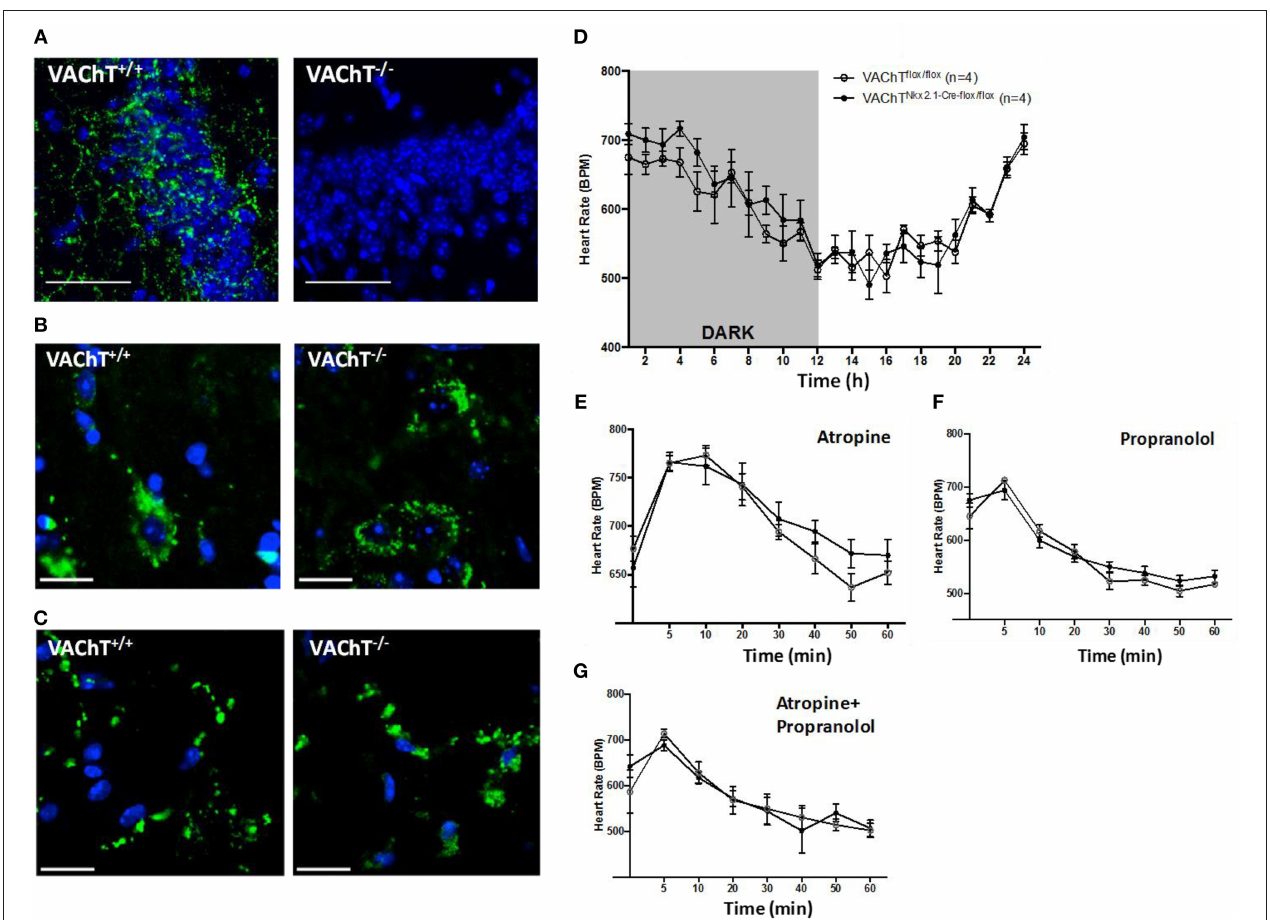
FIGURE 1 | Morphological and functional evaluation of forebrain VAChT KO mice. (A) VAChT protein immunostaining (in green) shown in a hippocampal region of VAChT + / + mice is not detected in VAChT − / − mice (scale bar = 100 µ m). (B) VAChT protein immunostaining (in green) in spinal cord of VAChT + / + and VAChT − / − mice (scale bar = 20 µ m). (C) VAChT protein immunostaining (in green) in the heart right atrium of VAChT + / + and VAChT − / − mice (scale bar = 20 µ m). (D) Freely moving VAChT flox / flox (VAChT + / + ) mice and VAChT Nkx2.1 − Cre − flox / flox (VAChT − / − ) mice exhibit no differences in heart rate during 24h recording using radio-frequency telemeters. Freely moving VAChT + / + (open circles) and VAChT − / − mice (black circles) exhibit no difference in heart rate responses to atropine (E) , propranolol (F) , or atropine and propranolol (G) i.p. administration ( n = 4